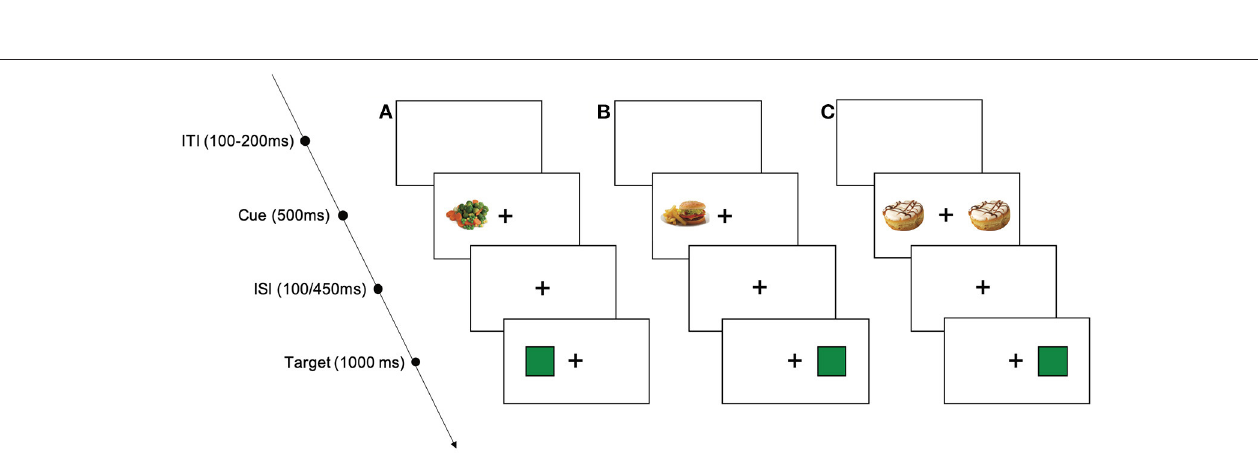
FIGURE 2 | Schematic procedure of the food cue attention task (FCAT): (A) , example of a valid trial with a low caloric food cue; (B) , example of an invalid trial with a high caloric food cue; (C) , example of a catch trial with high caloric food cues. ITI, intertrial interval; ISI, interstimulus interval.